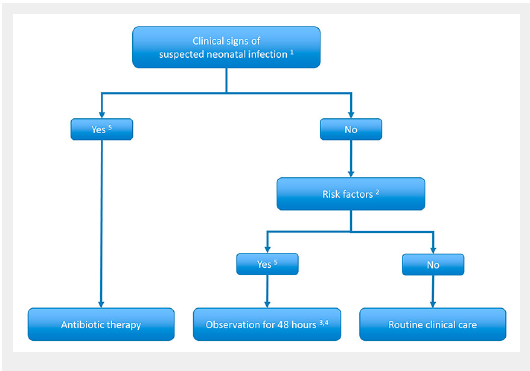
Management of term and late preterm infants (>34 weeks) at increased risk for neonatal bacterial infection (early-onset sepsis). (1.) Tachypnoea, respiratory distress, apnoea, tachycardia/ bradycardia, poor peripheral perfusion, mottling,